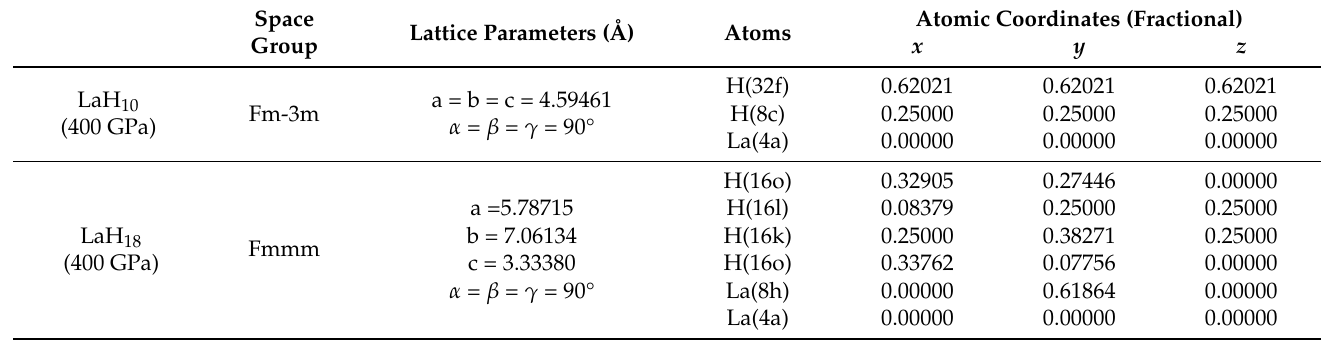
Table A1. The structural parameters of LaH 10 and LaH 18 were calculated and the results are shown below.